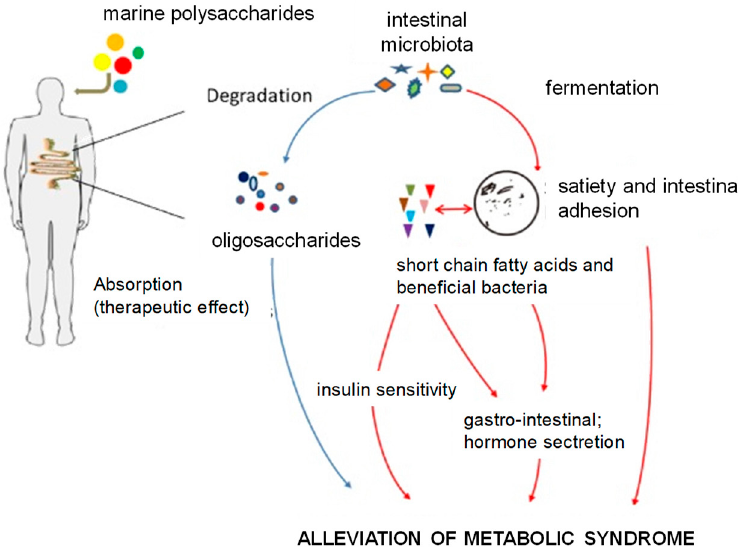
Figure 5. E ff ects of polysaccharides from marine algae on metabolic syndrome Figure 5. Effects of polysaccharides from marine algae on metabolic syndrome [116].